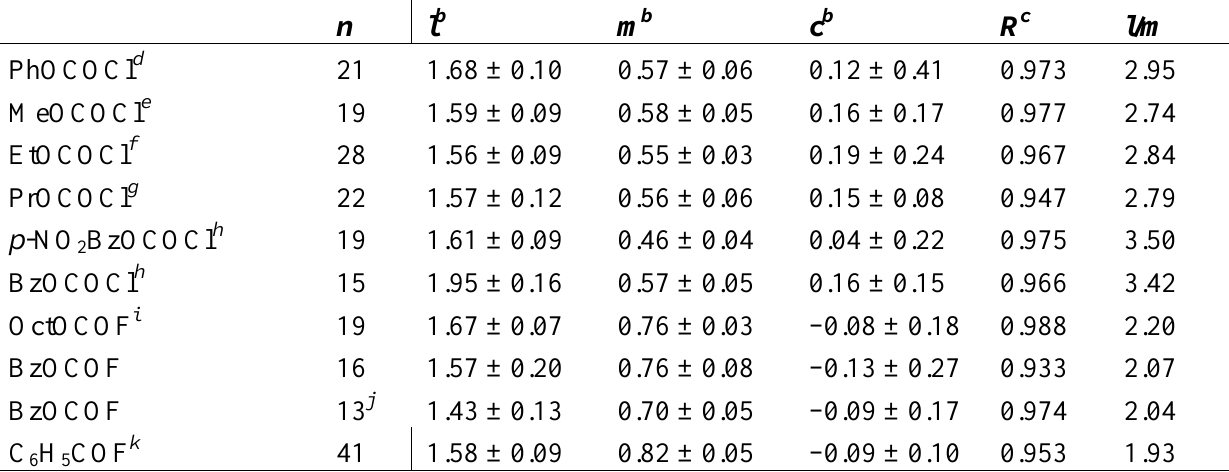
Table 3. Correlations a of the specific rates of the solvolyses by the addition–elimination mechanism for benzyl fluoroformate, several other chloroformate and fluoroformate esters, and benzoyl